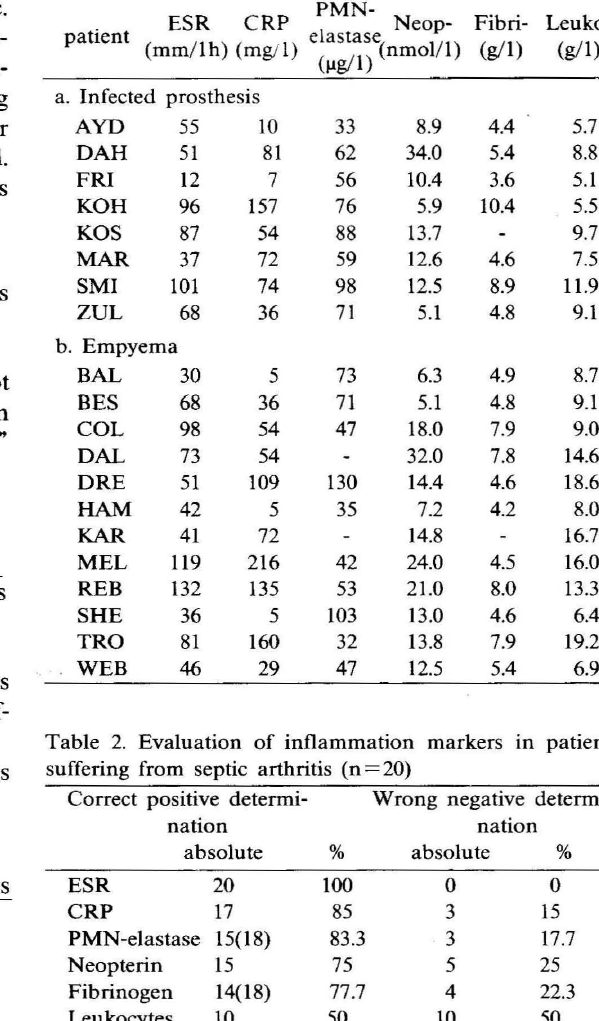
Table 1. Determination of inflammation markers (n=20)